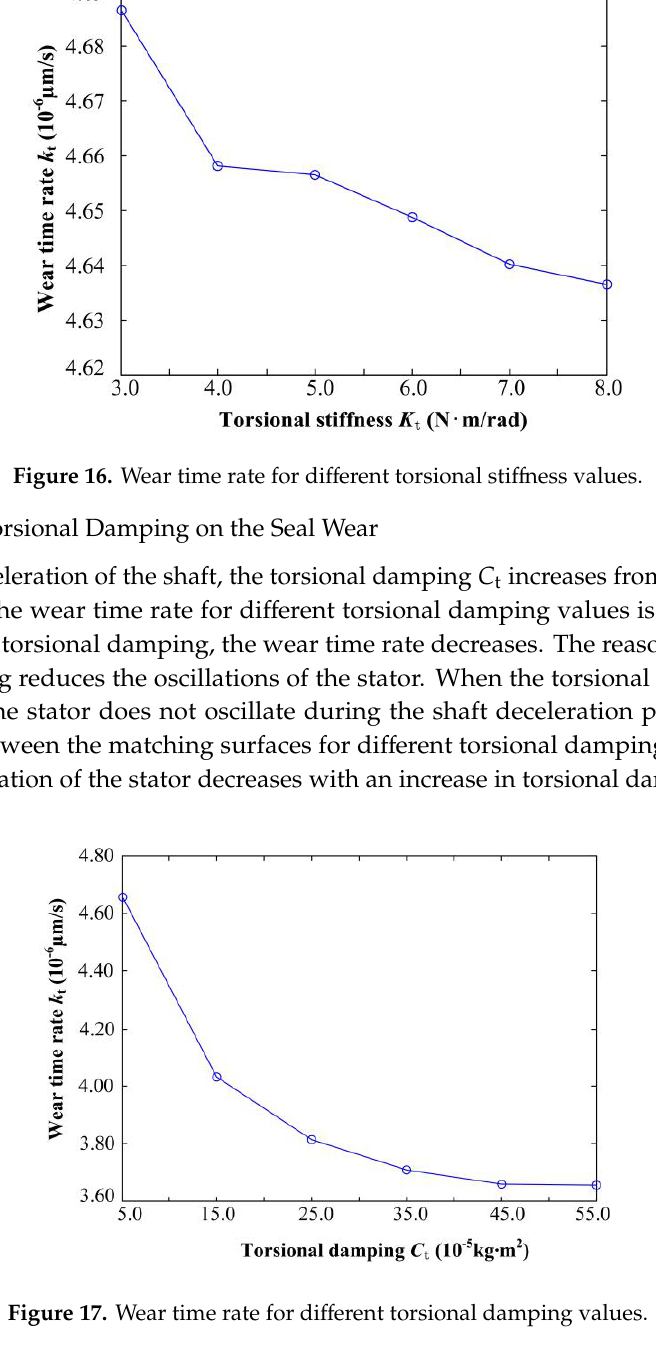
Figure 18. The relative angular speed ω during shaft deceleration. 6. Conclusions In this study, mechanical face seals for automotive cooling water pumps were investigated. Friction instabilities will occur in mechanical face seals when the axle decelerates or operates at a low speed. We conducted a fluid mechanics analysis, asperity contact mechanics analysis, dynamic analysis, and thermal analysis and investigated the influence of the surface parameters and dynamic parameters, such as the axial stiffness and torsional stiffness, on the wear of the seal.